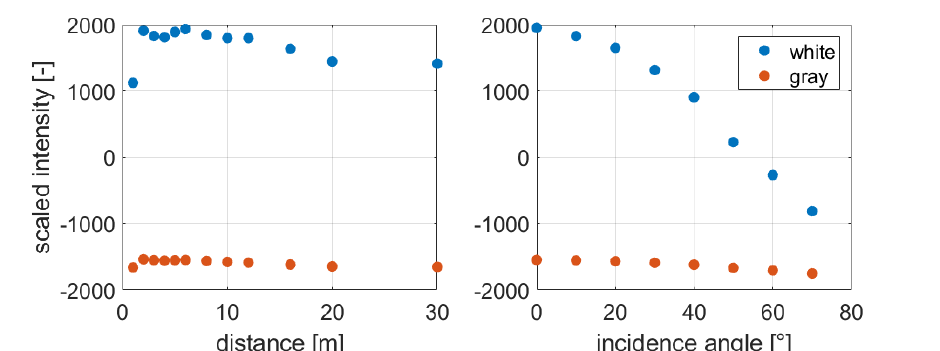
Figure 8. Left : Relation between scaled intensity and range; Right : Relation between scaled intensity and incidence angle for the Leica